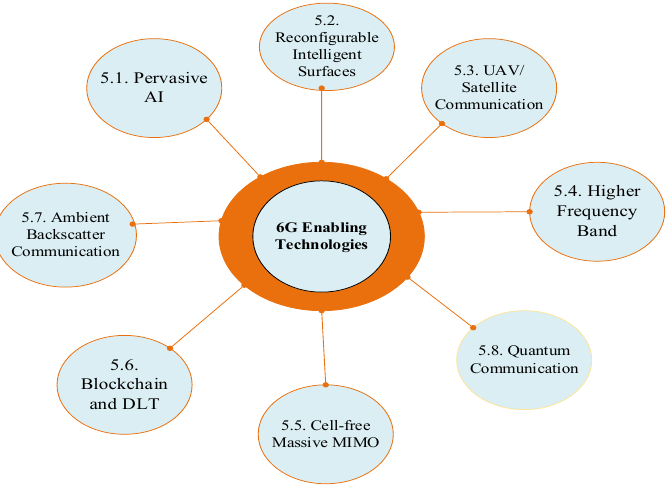
Figure 4. 6G Enabling Technologies.